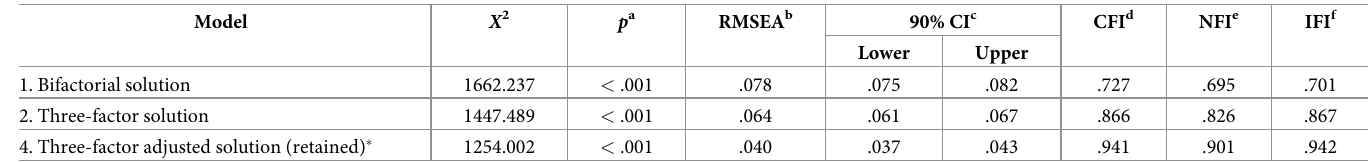
Table 2. Competitive CFA–goodness-of-fit indices obtained for the structural models.